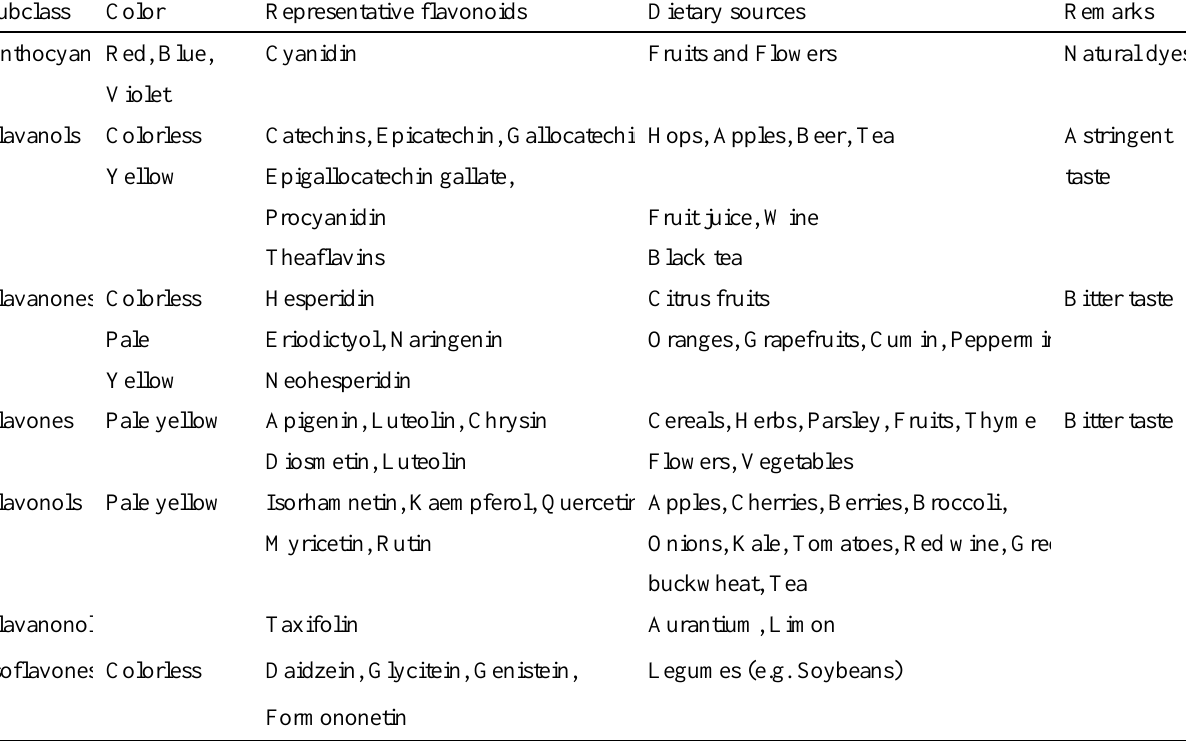
Table 1. Major classes of Flavonoids, Representative compounds, and Dietary sources [14] Subclass Color Representative flavonoids Dietary